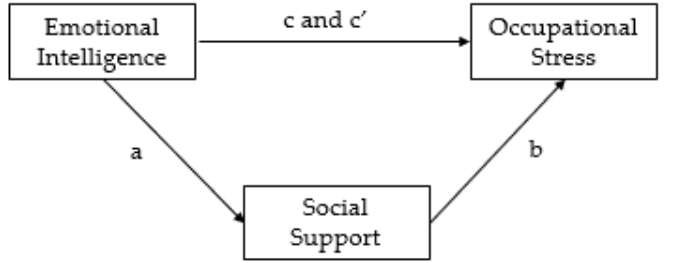
Figure 1. Conceptual model. Path a = association between EI and social support; path b = association between social support and occupational stress; path c = total effect of EI on occupational stress; c (cid:48) = direct effect of EI on occupational